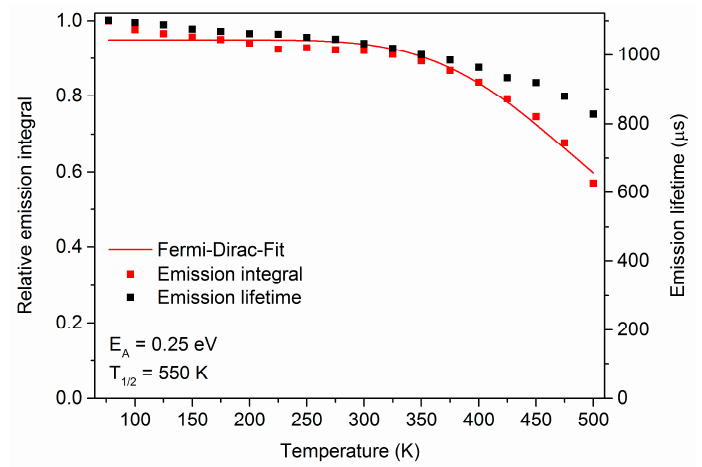
Figure 13. Emission integrals of Eu 3+ excited at 338 nm, and averaged decay lifetimes monitoring the 611 nm emission of (Gd 0.8 Eu 0.2 ) 3 Li 3 (Te 0.99 U 0.01 ) 2 O 12 .